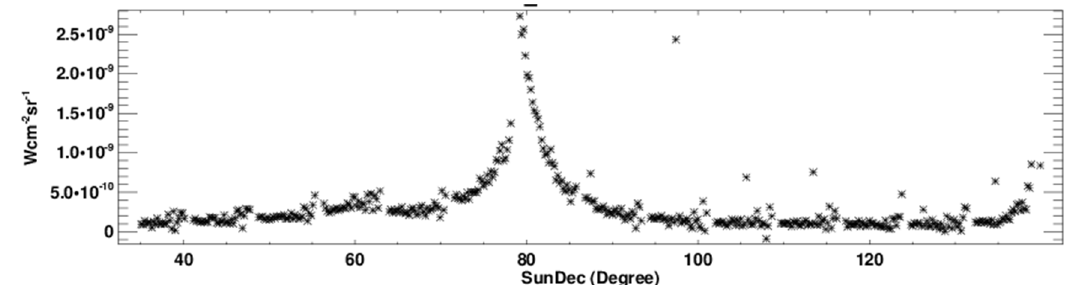
Figure 15. DNB HGA scan averaged SV signals plotted against spacecraft Sun declination angle (SunDec) for orbit 16,420 on December 28, 2014. The signal increase arounda Sun declination angle of 80 degrees corresponded to the timing when EV striping occurred at the beginning of the scan in Figure 14.